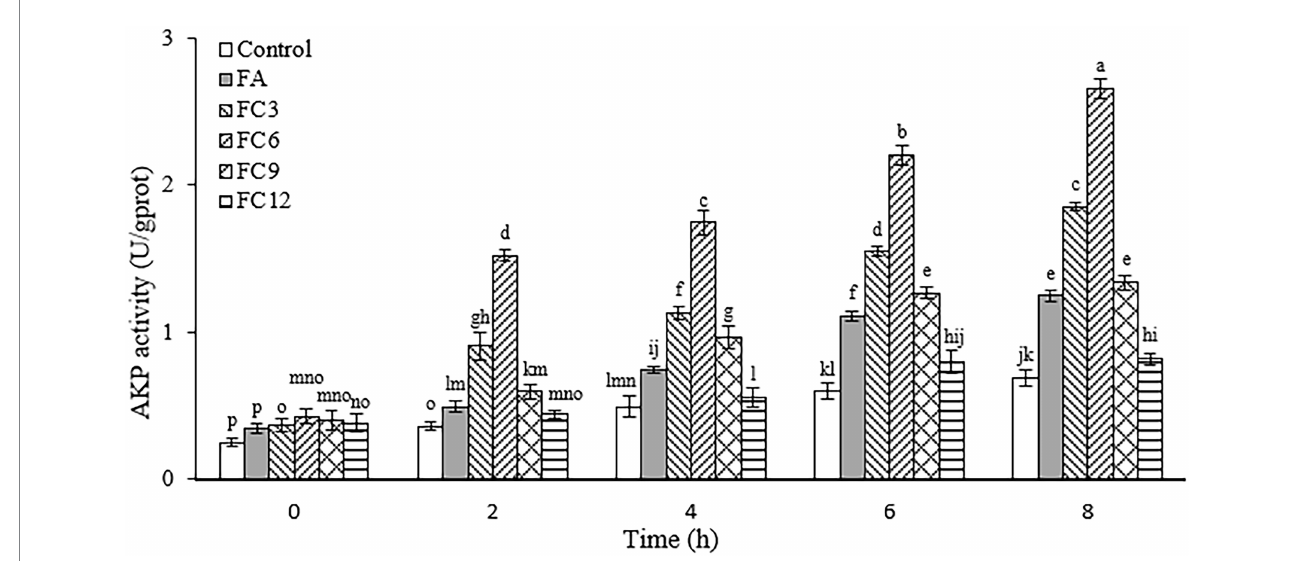
FIGURE 3 Effect on the integrity of Pseudomonas aeruginosa cell